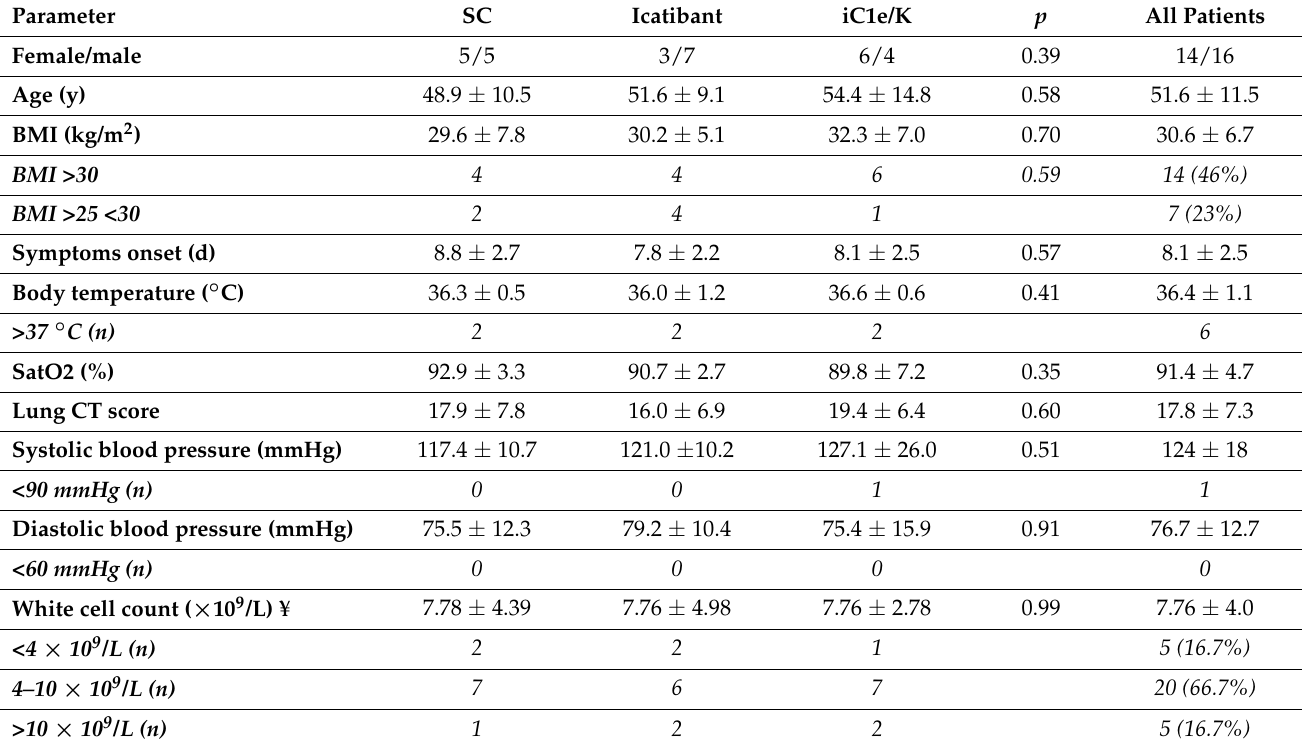
Table 1. Baseline parameters of patients included in the study.